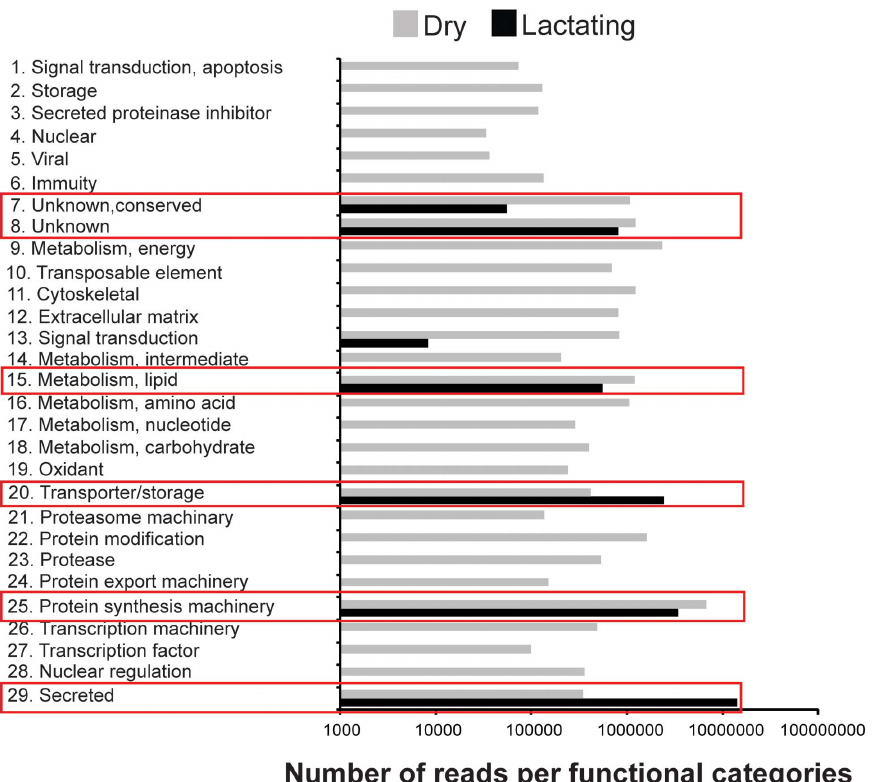
Figure 2. Gene ontology enrichment analysis. Reads in dry and lactating flies that mapped to genes with specific metabolic function.